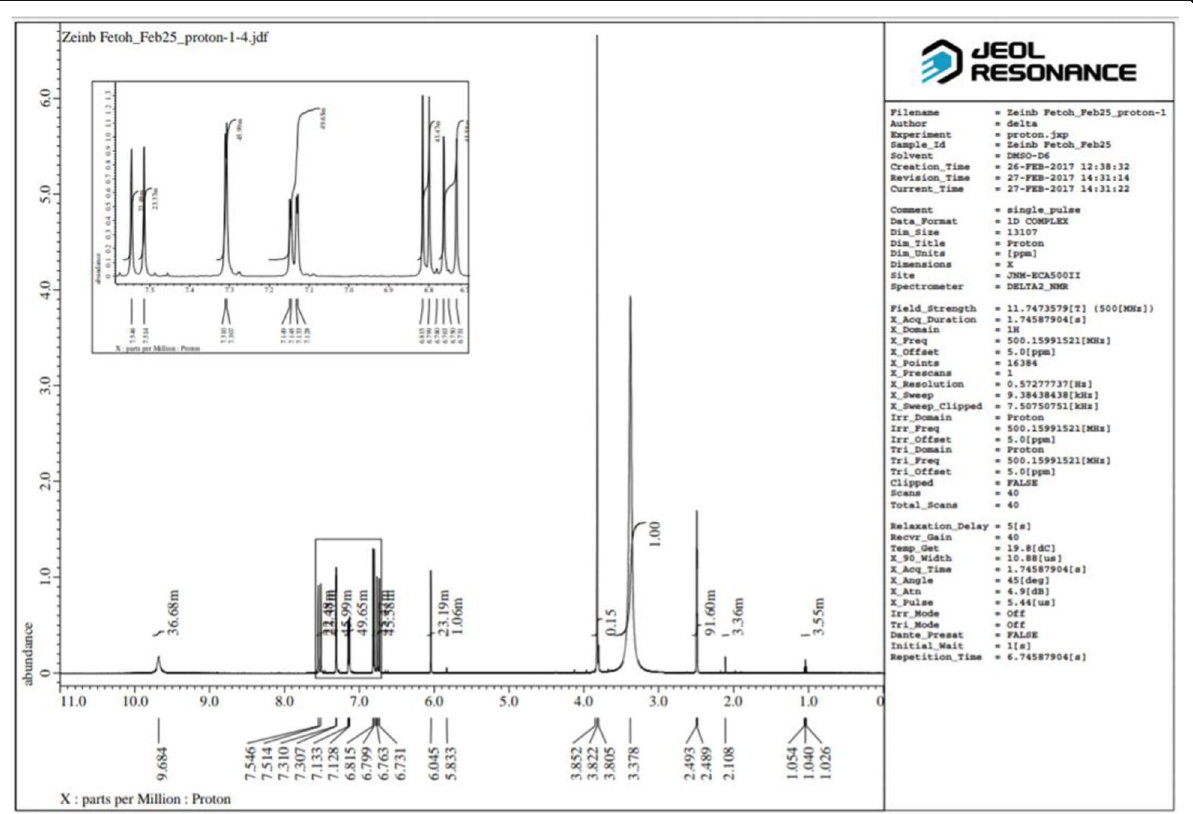
Fig. 4 1 H NMR (500 MHz) spectrum of curcumin in d 6